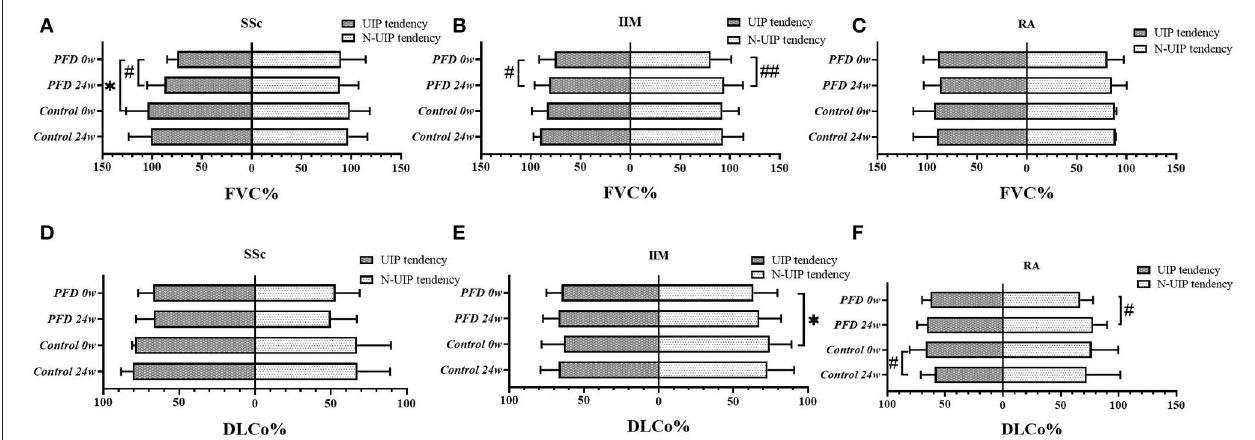
FIGURE 3 | The PF value in different HRCT subtypes of the 3 CTD-ILD groups at baseline and 24 weeks comparing PFD treatment with the no-PFD control treatment. The value of FVC% in patients with (A) SSc-ILD, (B) IIM-ILD, and (C) RA-ILD and the value of DLCo% in patients with (D) SSc-ILD, (E) IIM-ILD, and (F) RA-ILD at baseline and 24 weeks comparing the efficacy of PFD in UIP and non-UIP tendency subtypes with that of the no-PFD control. * p < 0.05 compared to the no-PFD control; # p < 0.05, ## p < 0.01 compared to baseline